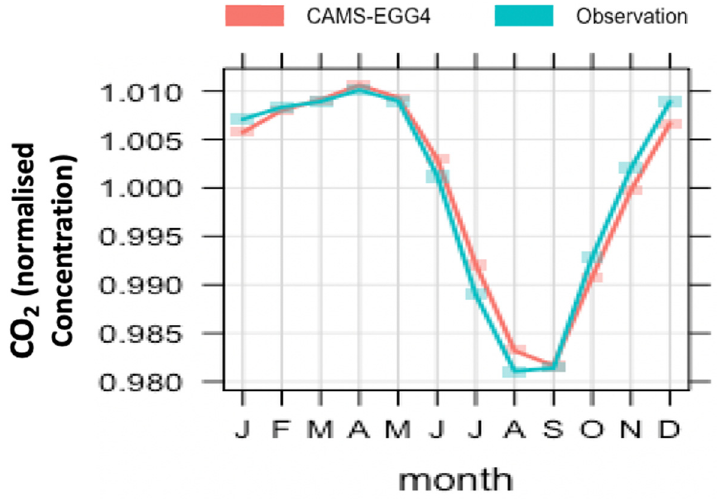
Figure 5. The annual CO 2 cycle displayed by observation and CAMS includes all northern hemisphere sites considered at this study. The line represents the kernel average of the monthly concentration of CO 2 , and the shaded area represents its variance in a 95% significance interval.